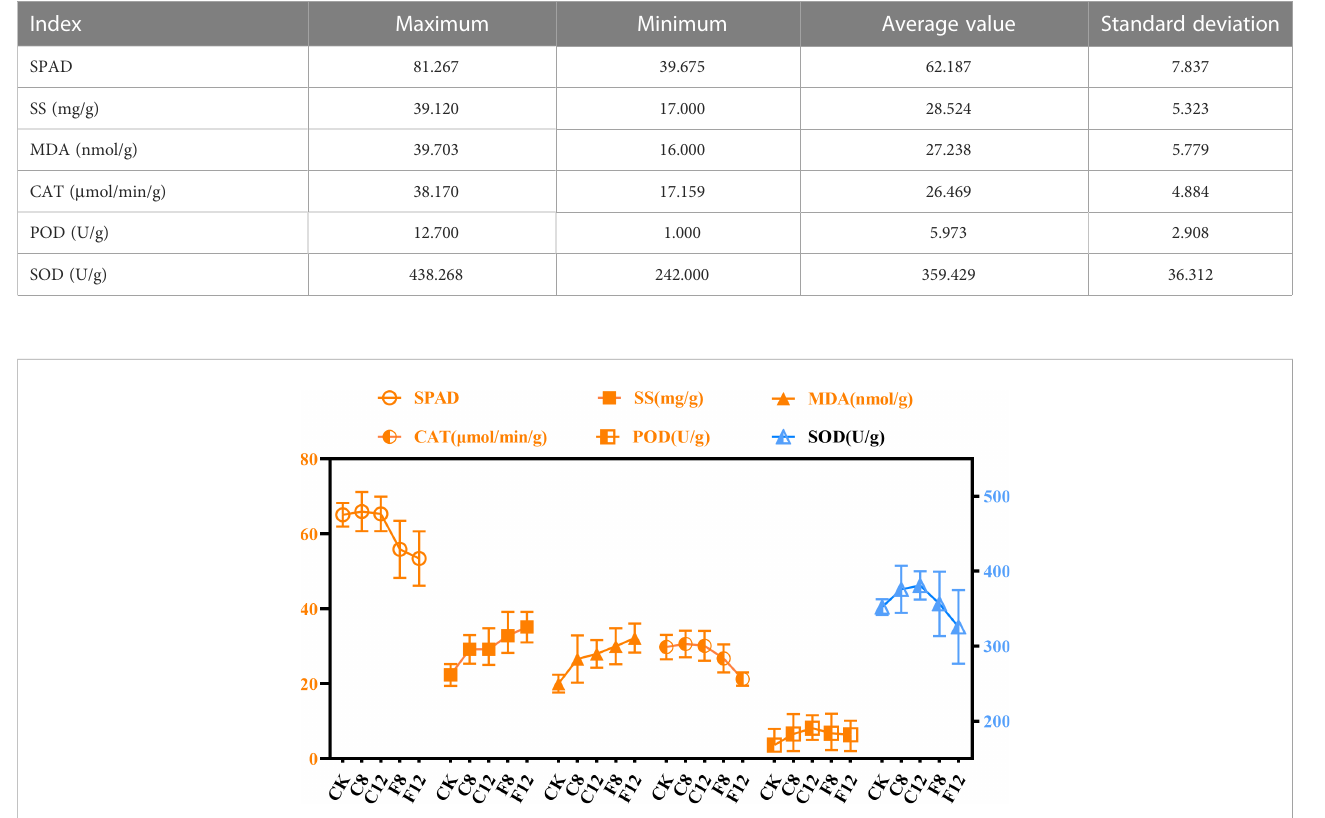
FIGURE 2 Data changes of low temperature-induced components under different low temperature conditions.